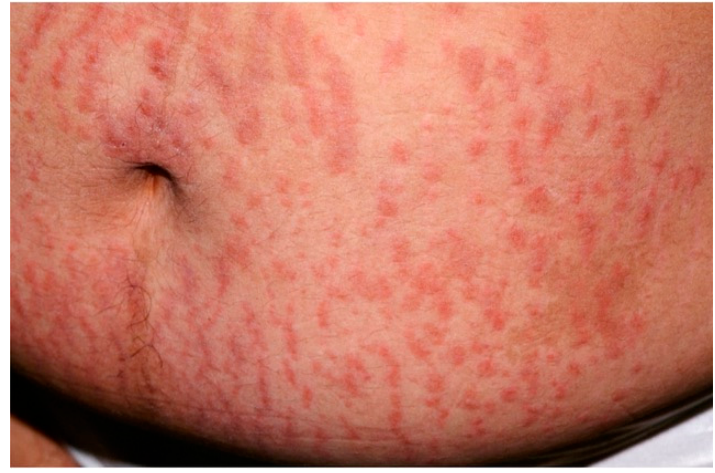
Figure 8. Clinical presentation of polymorphic eruption of pregnancy showing erythematous and edematous papules on a pregnant abdomen and within the striae distensae.